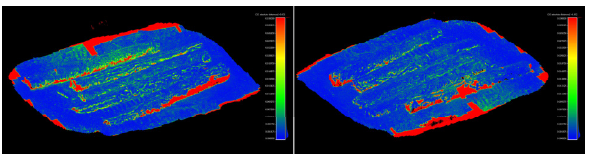
Figure 10. Point clouds of Nikon nadiral image photogrammetric survey. Compared distance with points cloud obtained by Nikon radial images.